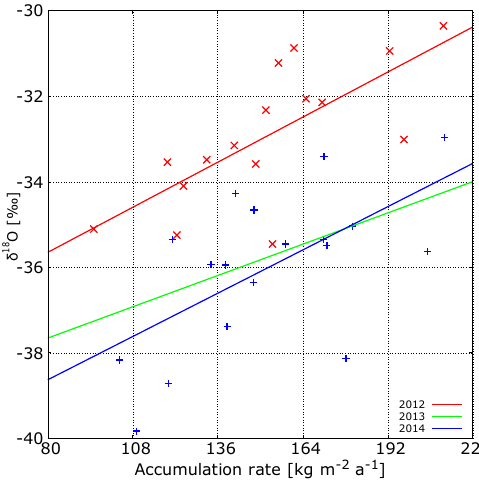
Figure 10. δ 18 O signal vs. accumulation rate for the years 2012– 2014. The lines were obtained by linear least squares fitting with coefficients of determination of R 2 = 0.52 for 2012, R 2 = 0.27 for 2013 and R 2 = 0.37 for 2014. The data points for 2013 show the largest spread and were omitted for